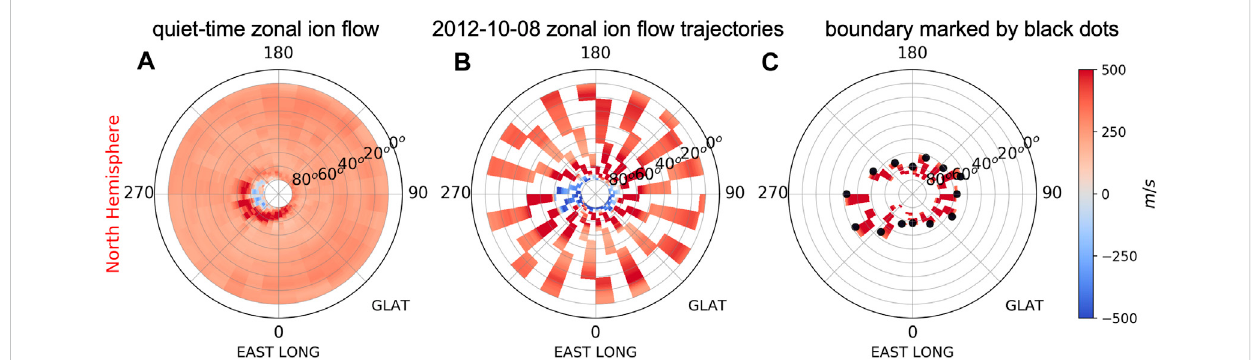
FIGURE 1 Example showing the identi fi cation of determining the ion convection equatorial boundaries in the Northern Hemispheric dusk side for DMSP F16. DMSP measured (A) quiet-time zonal ion fl ow background; (B) 2012 – 10 – 08 storm-time zonal ion fl ow trajectories; and (C) 2012 – 10 – 08 storm-time zonal ion fl ow after the identi fi cation. The positive and negative values represent the sunward and anti-sunward fl ows, respectively. The ion convection equatorial boundaries are marked by black dots in the third column (C) . The radius represents the geographic latitude (GLAT), and the polar angle represents geographic longitude (GLON) at a fi xed LT, ~18 SLT, or universal time (UT = GLON/15. — 18 LT).